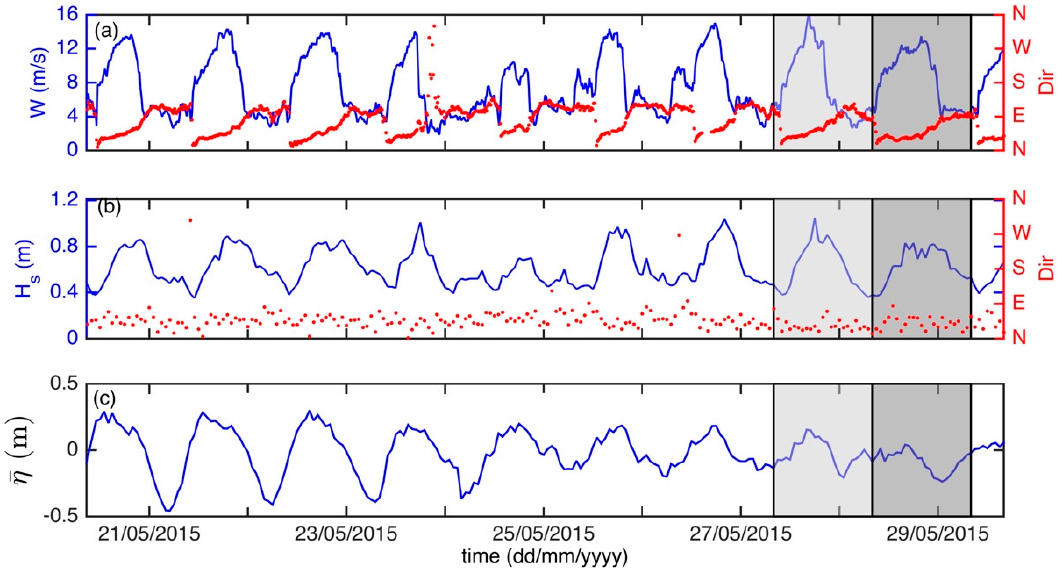
Figure 7. Measured ( a ) wind speed and wind direction ( b ) offshore significant wave height and wave direction at 10 m water depth and ( c ) mean sea level variation 𝜂̅ from the Sisal gauge before, during (light gray shade) and after (dark gray shade) the groin deployment.